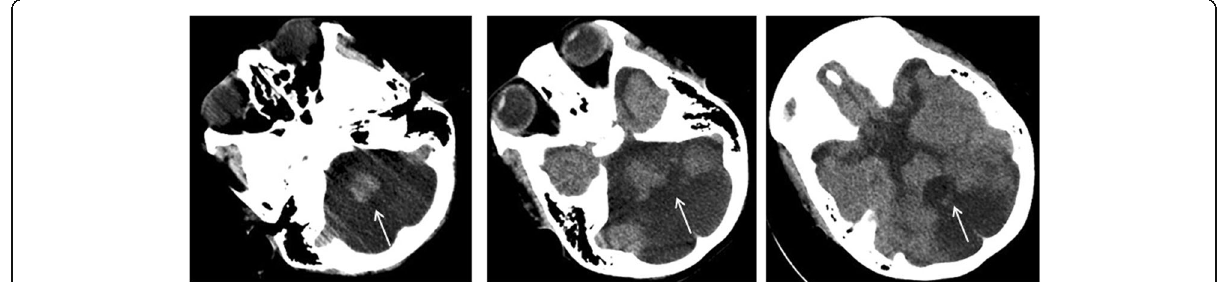
Fig. 2 CT imaging showed the unclear of cerebellar vermis and enlarged fourth ventricle of the